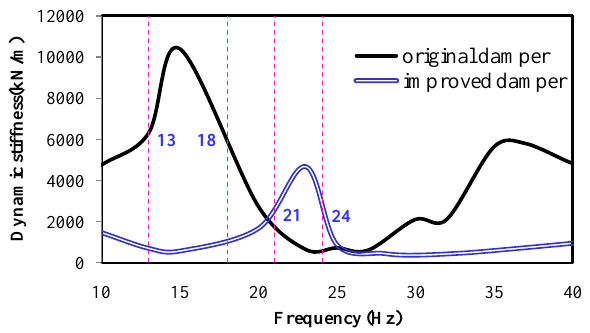
Figure 9. Dynamic stiffness comparison of the cab absorber.